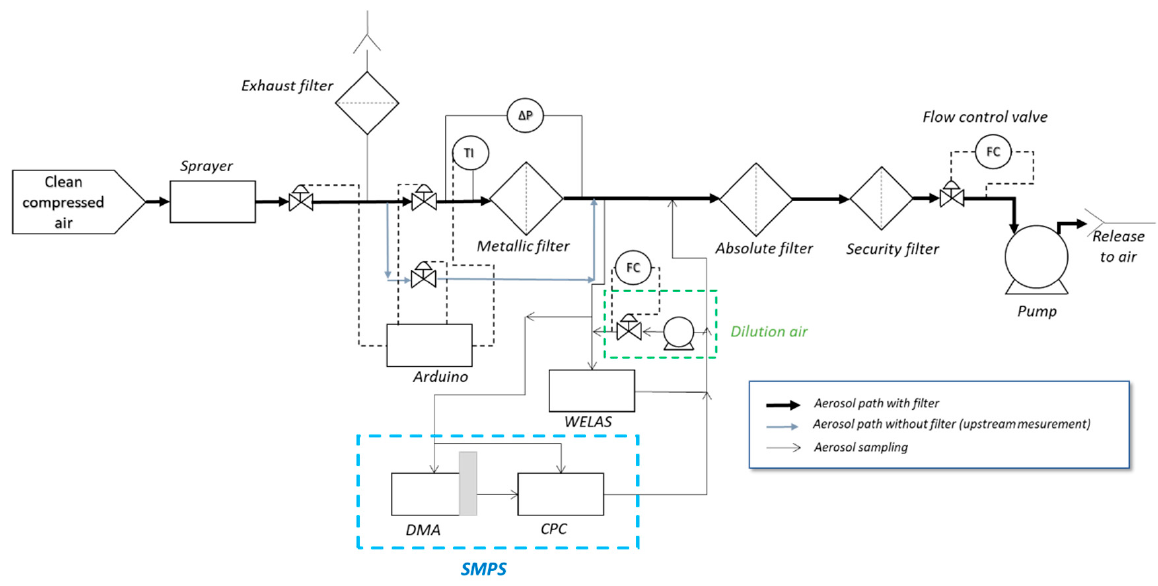
Figure 2. Experimental set-up. The test aerosol is produced using a Pallas AGF 2.0 nebuliser from a DEHS (di(ethylhexyl) sebacate) in order to avoid the evaporation of liquid droplet during the experiment. The number mean diameter measured is around 250 nm. According to the SMPS measurement (CPC 3752 and DMA 3082), the aerosol follows a log-normal distribution with a geometric standard deviation of 1.7 and a number median diameter of 354 nm. A log normal fitting has been applied on the measured distribution to compute the mass concentration upstream